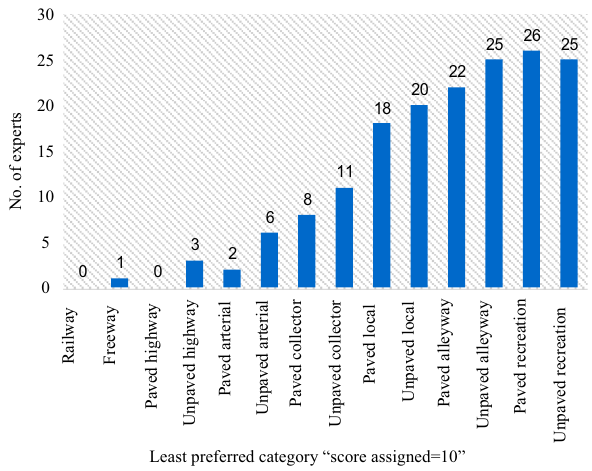
Fig. 4 Least preferred means of transportation for nuclear materials with rank score of ‘10’